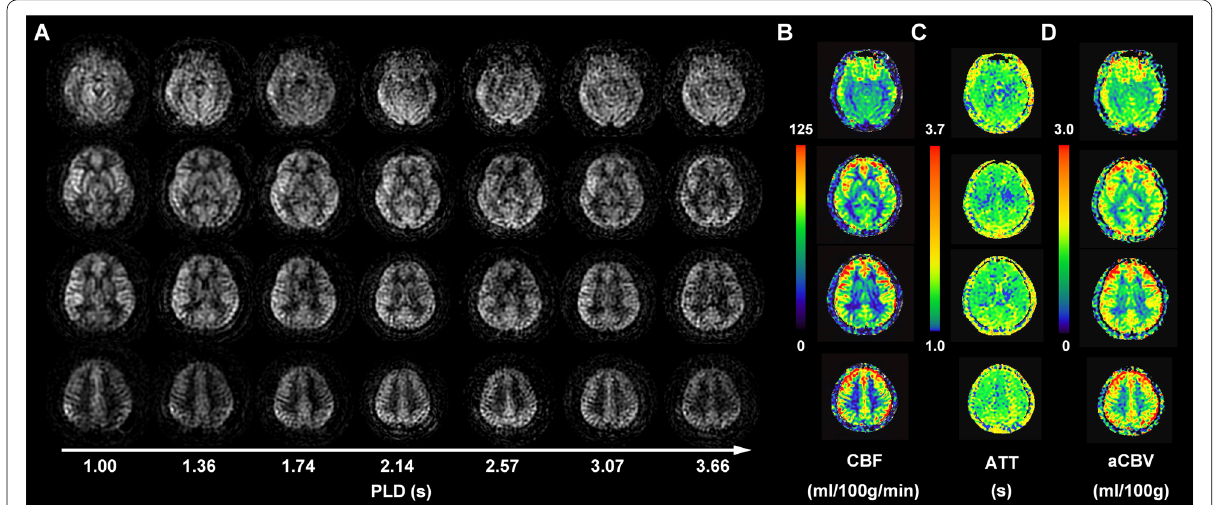
Fig. 1 Diagram of cerebral perfusion by multi-delay ASL MR imaging. ( A ) The raw maps of ASL imaging, including different post label delays (PLDs) ranging from 1.00 to 3.66 seconds (s). ( B ) The arrival-time-corrected cerebral blood flow (CBF) colormaps. ( C ) The arterial arrival time (ATT) colormaps. ( D ) The arterial cerebral blood volume (aCBV)